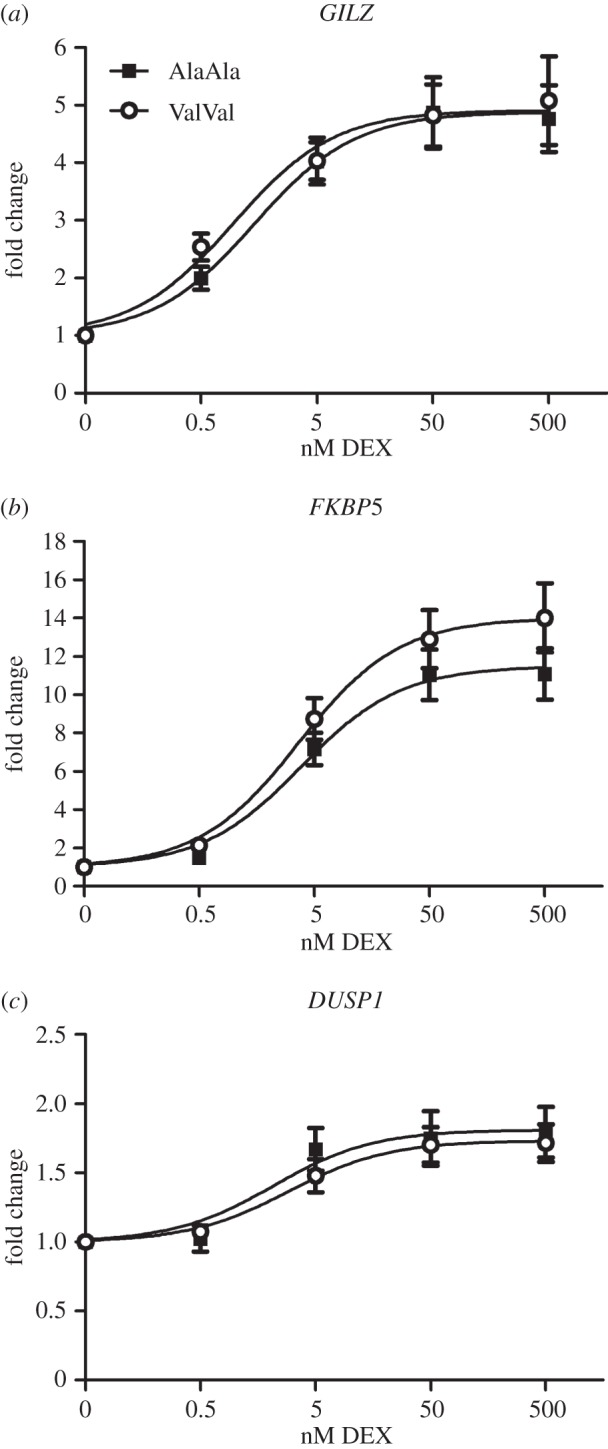
Transcriptional activation in ConA-stimulated PBMCs in response to DEX treatment ex vivo: (a) GILZ; (b) FKBP5; (c) DUSP1. Gene expression was measured using quantitative real time PCR. Data are presented as dose–response curves estimated based on fold-changes calculated within each individual relative to control treatment with ConA but without DEX. Individual points show means ± s.e. Estimated half-maximal effective concentrations (EC50) for AlaAla (n = 9) compared to ValVal (n = 10) carriers were: (a) 1.445 versus 0.957 nM (p = 0.561) for GILZ; (b) 3.857 versus 3.686 nM (p = 0.932) for FKBP5; (c) 2.156 versus 2.948 nM (p = 0.932) for DUSP1.